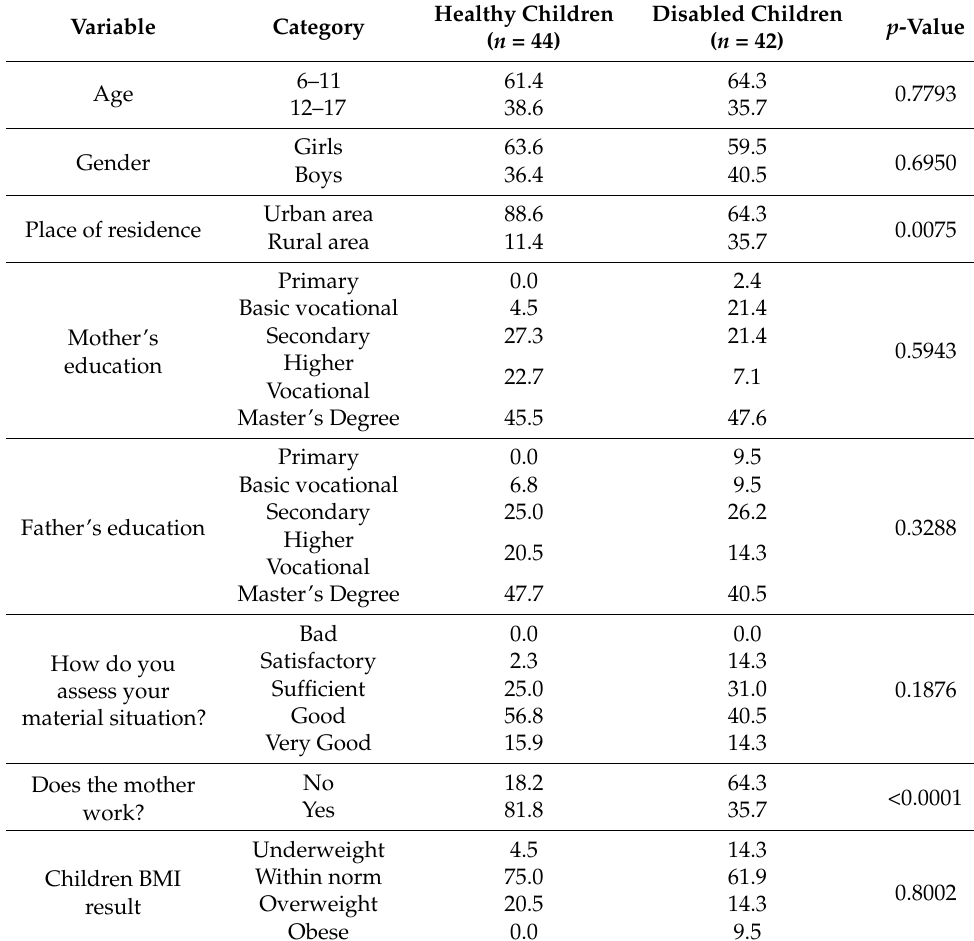
Table 1. Socio-demographic characteristics and nutritional status of children, including healthy and disabled